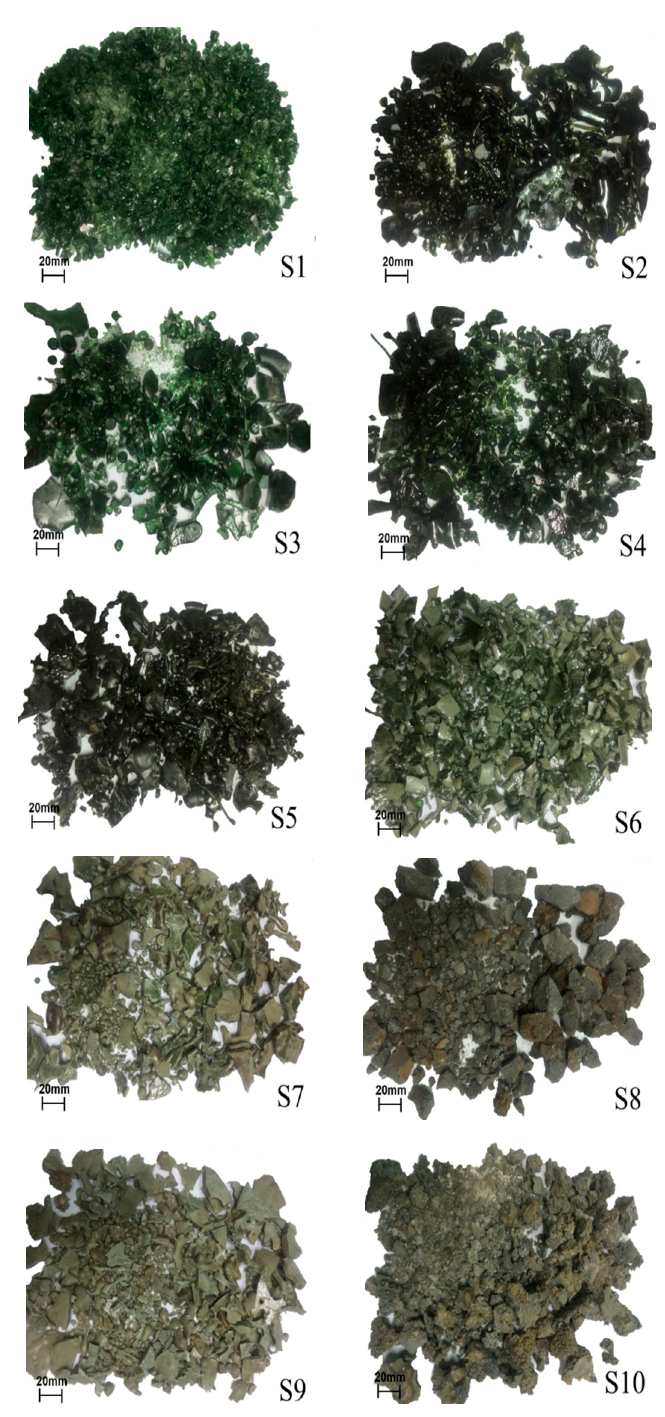
Figure 4. Photographs of synthetic air quenched slags.